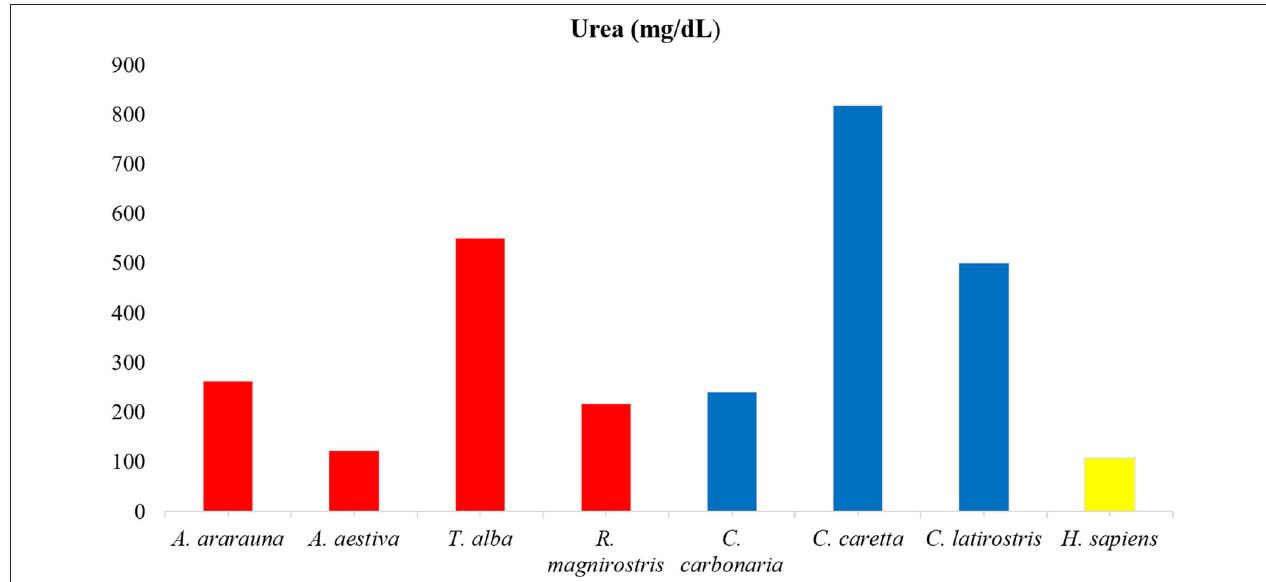
FIGURE 2 | Amounts of urea in tears of birds, reptiles, and humans. Note high urea content in Caretta caretta tears and lower content in humans.